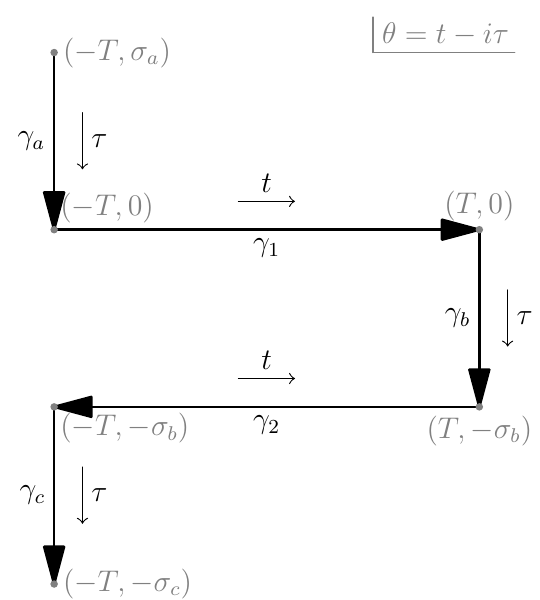
Figure 14. General Keldysh contour given by